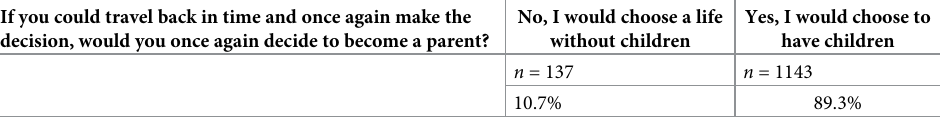
Table 8. Percentage of Polish parents aged 18–30 who regretted having a child (Study 2). If you could travel back in time and once again make the decision, would you once again decide to become a parent?